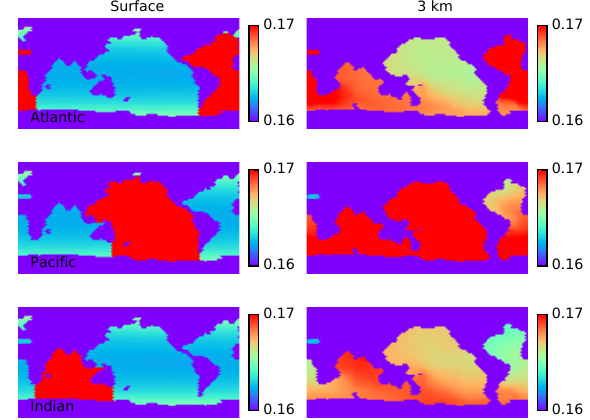
Figure 17. Maps of steady-state distribution of (cid:49) 200 Hg(II) under conditions of a doubling of the Hg(II) deposition flux which is iso- lated to the Atlantic, Pacific, and Indian oceans. The isotopic signa- ture at 3km depth reflects differences in surface